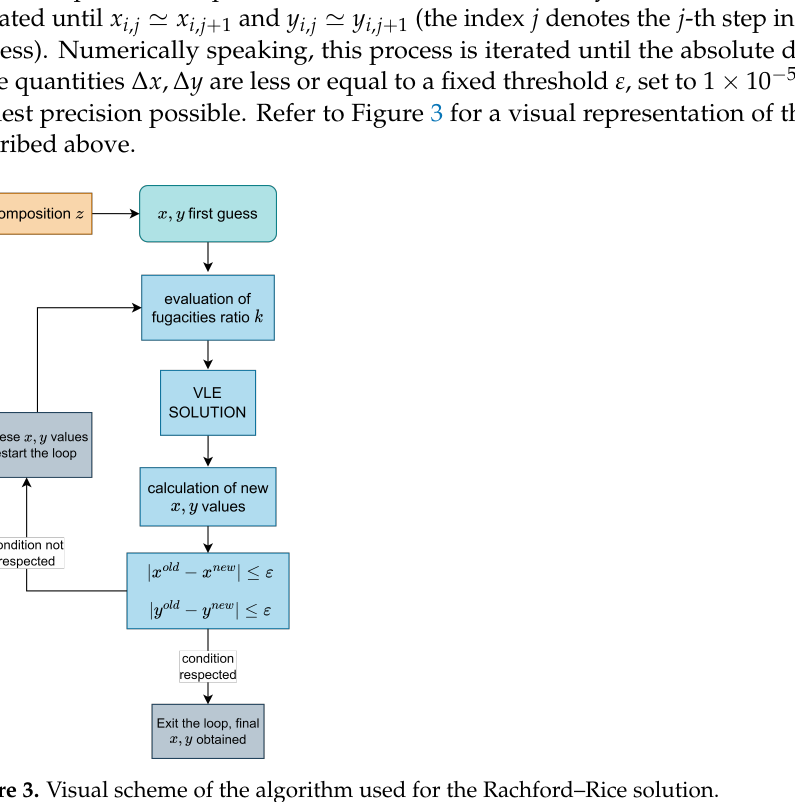
Figure 3. Visual scheme of the algorithm used for the Rachford–Rice